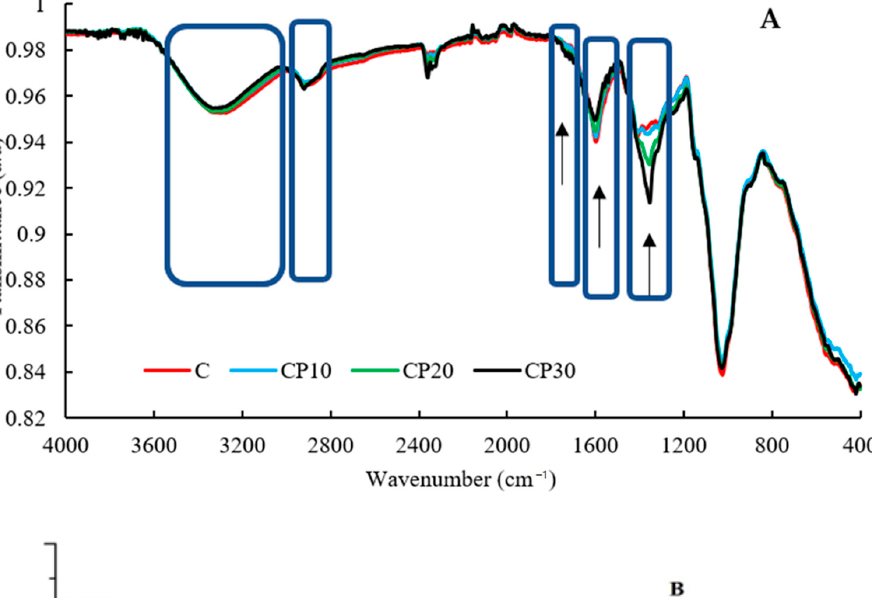
Figure 1. SEM micrographs (× 20,000 magnification) of BSG powder treated by cold plasma (CP); C, CP 10 , CP 20 , and CP 30 indicate unmodified samples and those treated by CP for 10, 20, and 30 min, respectively.